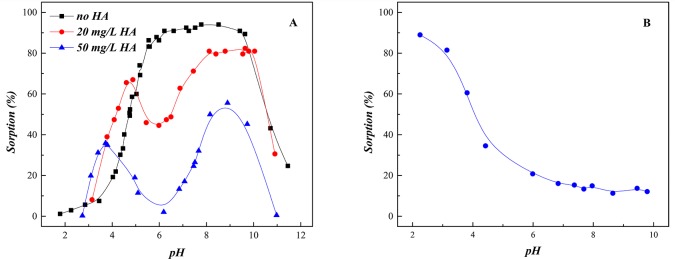
The influence of HA on the interaction between U(VI) and SONPs (T = 298±1 K, I = 0.01 mol/L NaClO4, s/l = 0.6 g/L).(A) The influence of HA on U(VI) sorption edge on SONPs ([U(VI)] = 2.0×10−5 mol/L). (B) HA sorption edge on SONPs ([HA] = 20 mg/L).